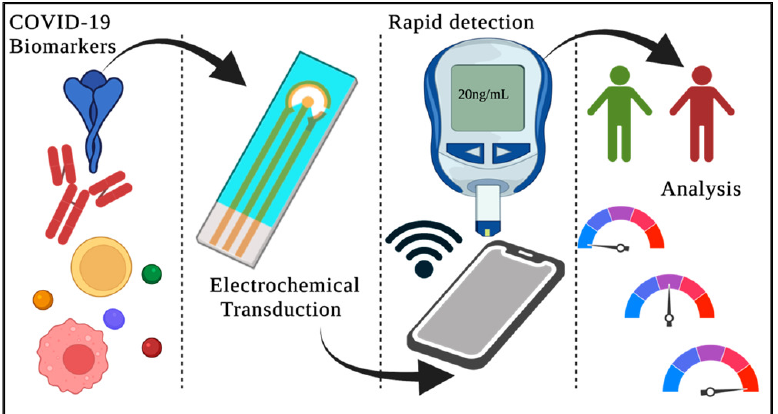
Figure 8. Schematic diagram of a point-of-care test. Reproduced with permission from [39]. Repro- duced with permission from [39], Creative Commons.